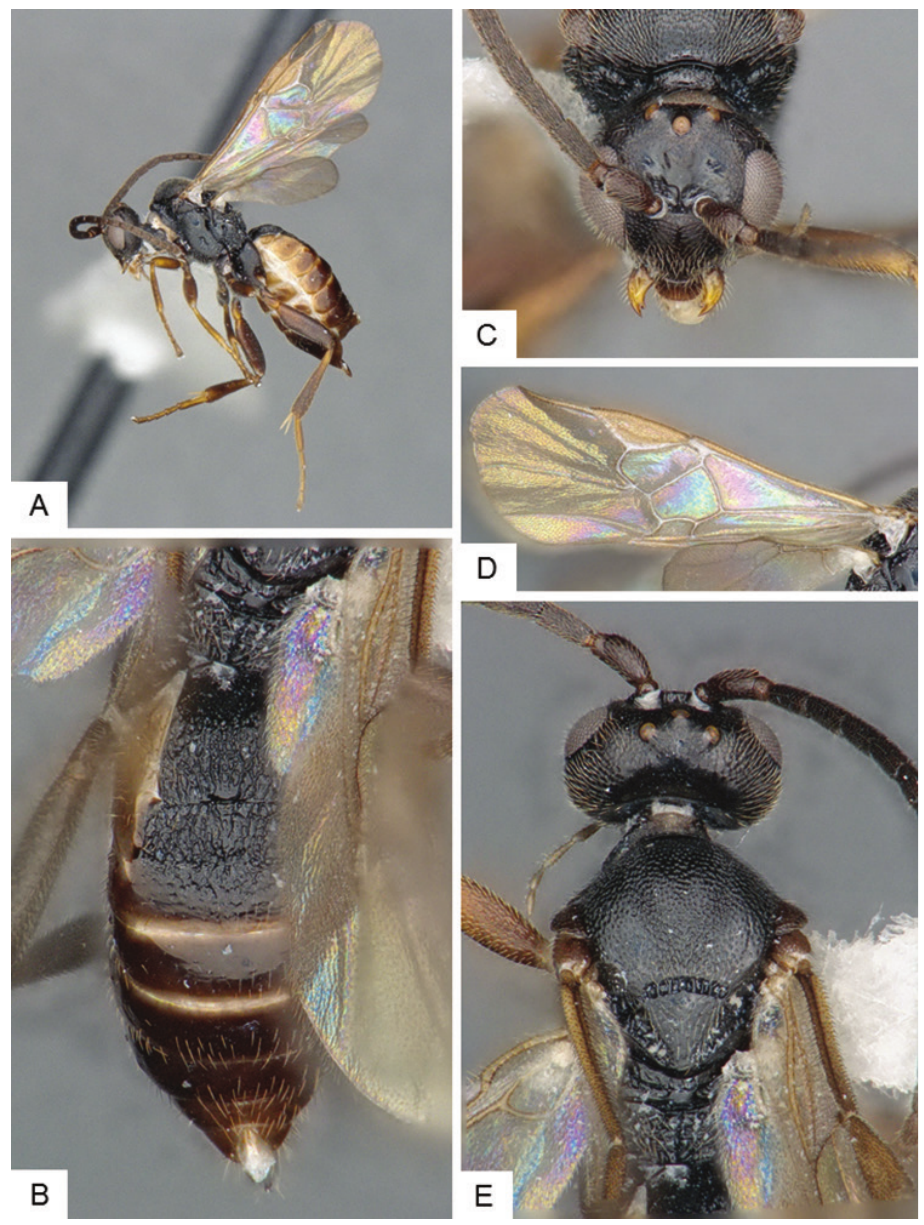
Figure 5. Cotesia sp. 2. A Habitus, lateral B Metasoma, dorsal C Head, frontal-dorsal D Fore wing E Head and mesosoma,